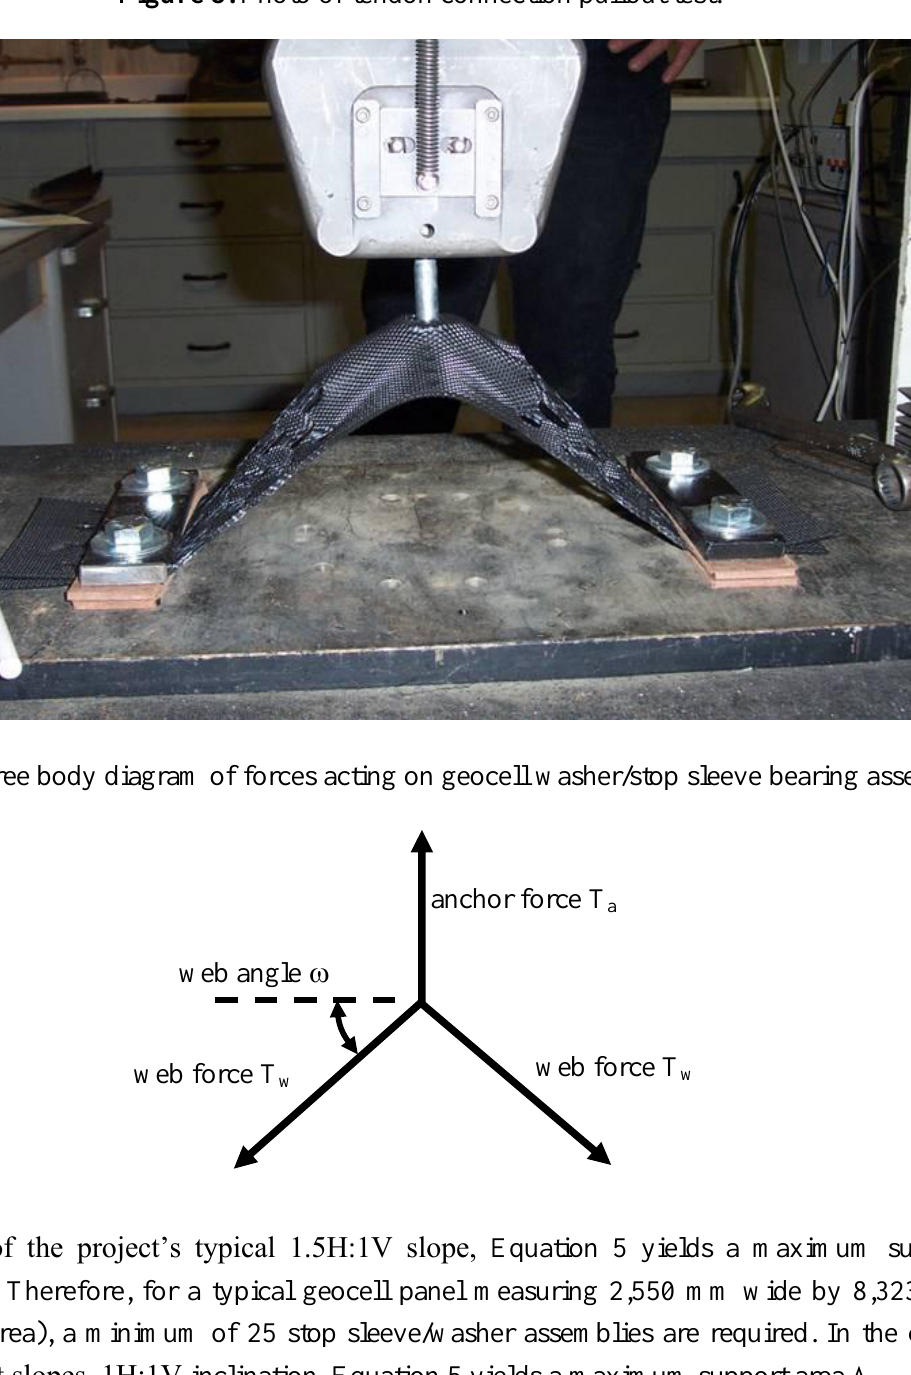
Figure 8. Photo of tendon connection pullout test.